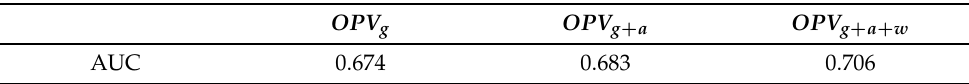
Table 3. Visual tracking performance of the proposed object proposal voting (OPV) according to different settings for the terms in (8). OPV g , OPV g + a , and OPV g + a + w denote the proposed visual tracker using position, position+appearance, and position+appearance+vote weight terms, respectively. OPV g